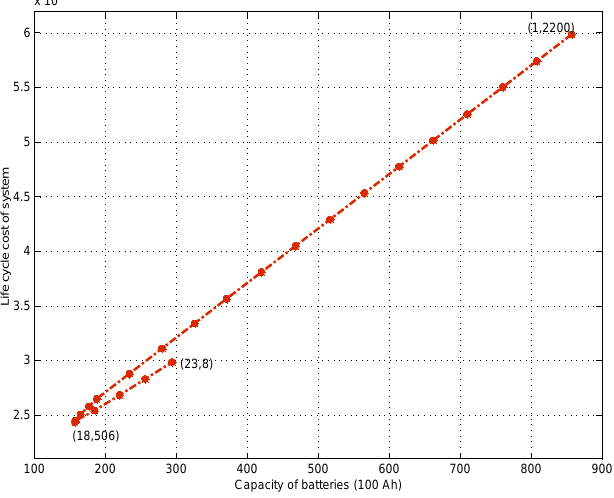
Figure 6. Sizing results of the hybrid system in each